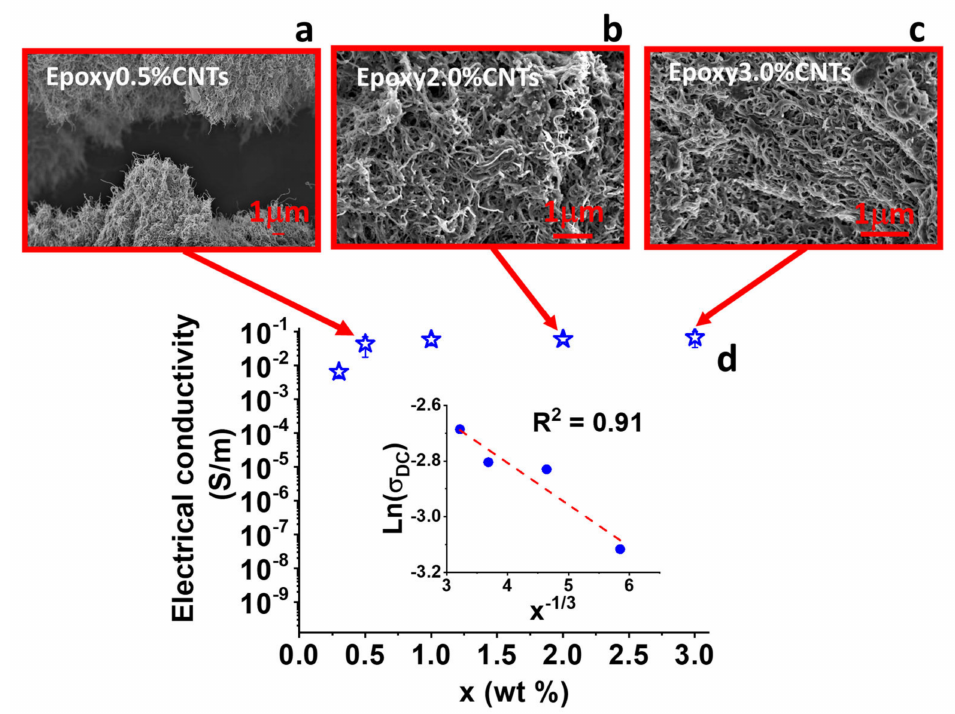
Figure 3. SEM images of epoxy systems filled with ( a ) 0.5, ( b ) 2.0, and ( c ) 3.0% by weight; ( d ) electrical conductivity behavior of the CNTs system. Inset: the relationship between the electrical conductivity, in logarithmic scale, and x − 1/3